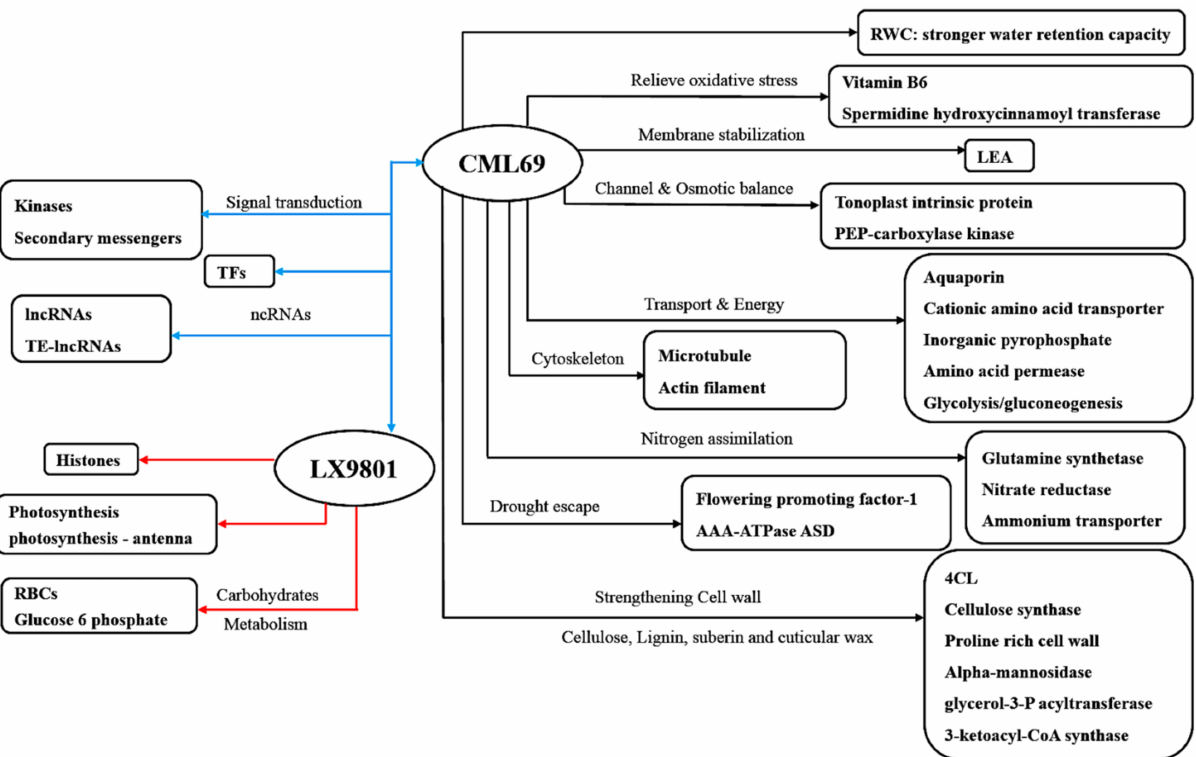
Figure 8. The schematic molecular model describing the main pathways involved in the acquisition of drought tolerance in maize seedling. The model was constructed based on our main common drought-responsive genes identified in this report, as well as plant abiotic stress pathway schemes previously described. The black and red pointing arrows display the main pathways which were enriched in CML69 and LX9801, respectively. The blue pointing arrows display the common pathways in both drought-tolerant and sensitive inbred lines. Abbreviation’s key: RWC, relative water content; LEA, late embryogenesis abundant; CL, coumarate-CoA ligase; TFs, transcription factors; ncRNAs, noncoding RNAs; lncRNAs, long noncoding RNAs; TE-lncRNAs, transposable elements long noncoding RNAs; RBCs, ribulose